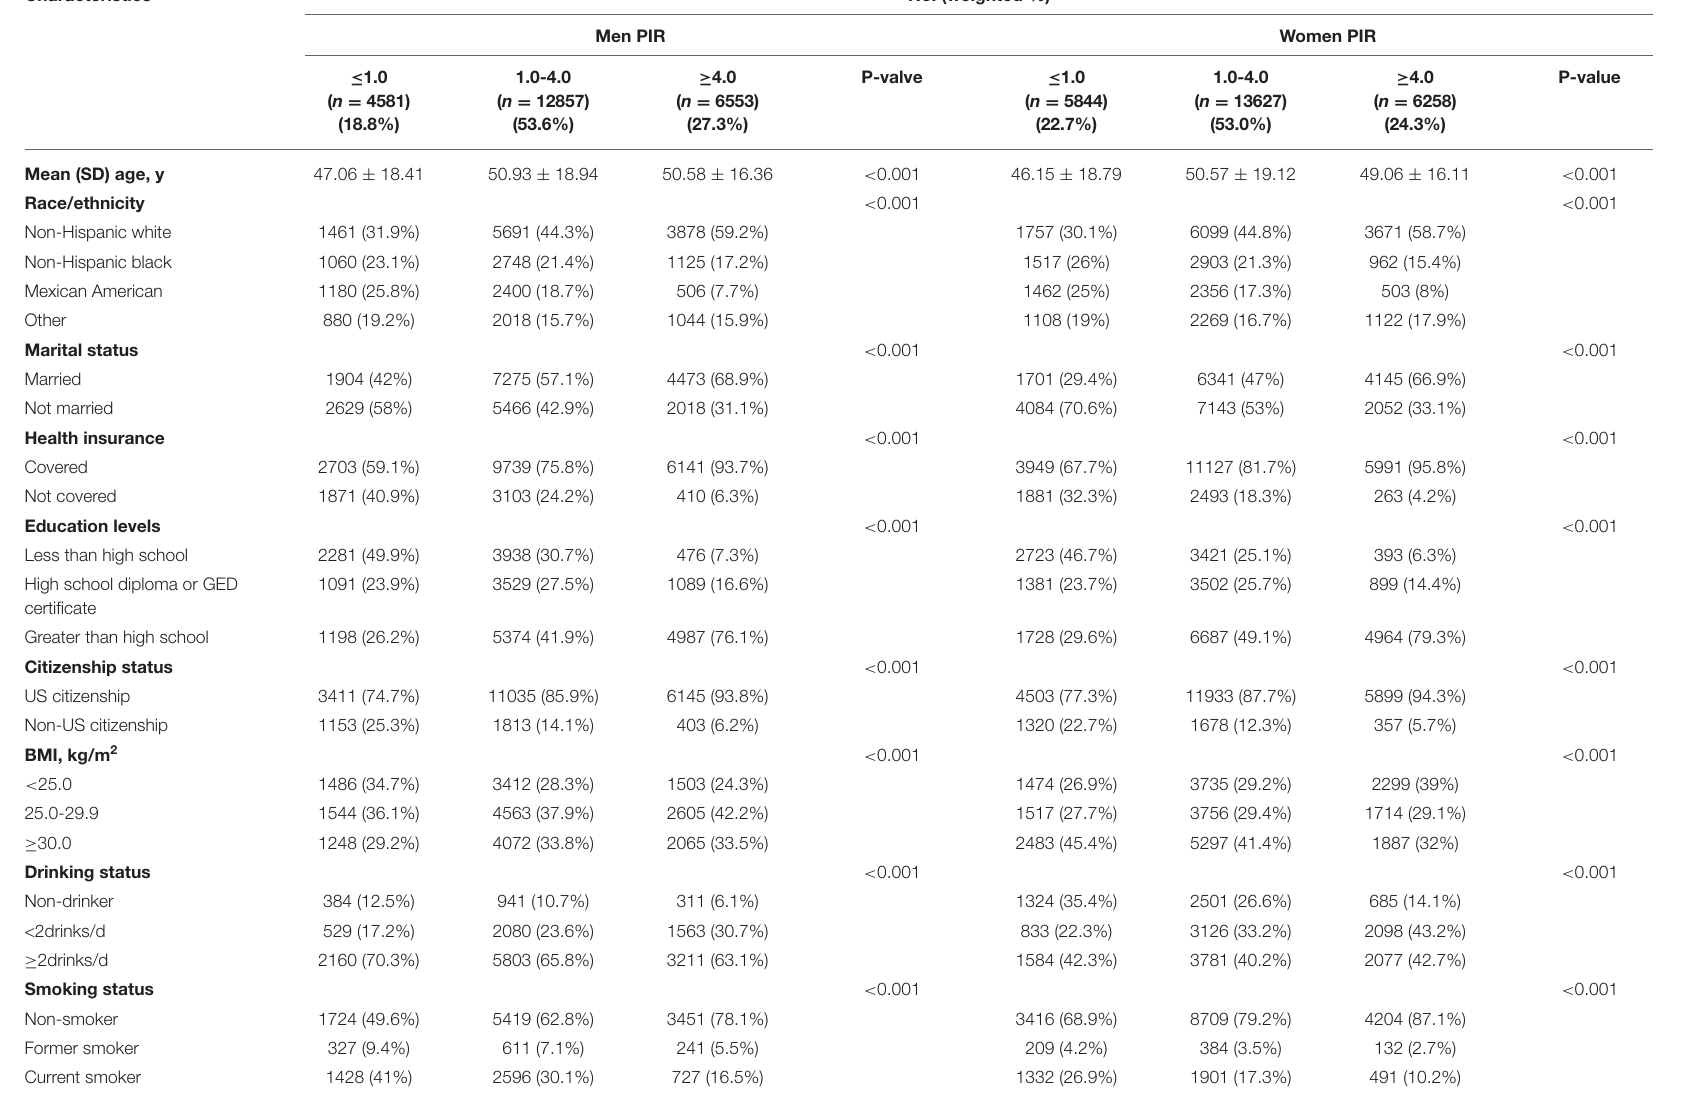
TABLE 1 | Characteristics of study participants,